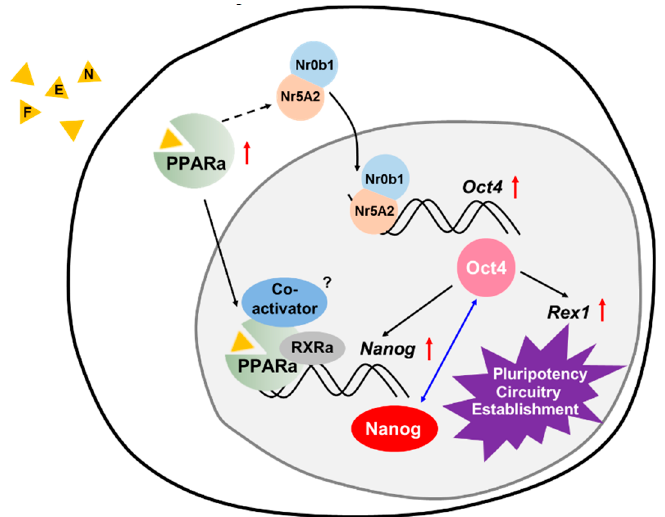
Figure 6. Pharmacological regulation of pluripotency circuitry establishment during cellular reprogramming via the FEN-stimulated PPAR α regulatory pathway. Nr5a2 increased by FEN may interact with Nr0b1 and function in Oct4 upregulation together, resulting in the target activation of Oct4 itself, Rex1, and Nanog. Nanog was also identified as a direct target of PPAR α and then transcriptionally activated with or without coactivators.